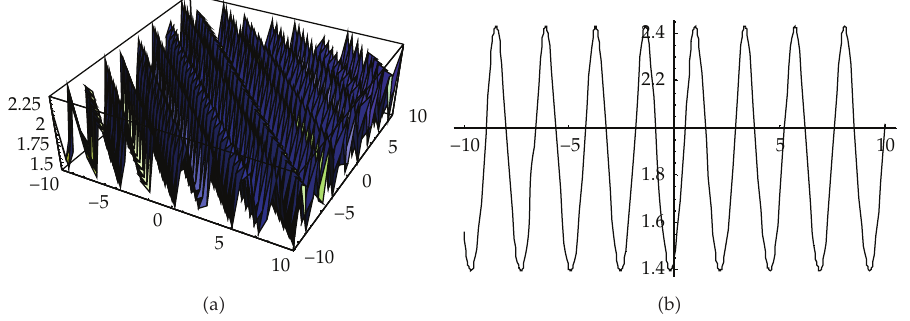
Figure 3: (cid:3) a (cid:4) The graph of (cid:3) 3.17 (cid:4) with a (cid:8) r (cid:8) σ (cid:8) 1 , b (cid:8) 2 , m (cid:8) 0 . 99 at t (cid:8) 1, and (cid:3) b (cid:4) is its plane when y (cid:8) 0.